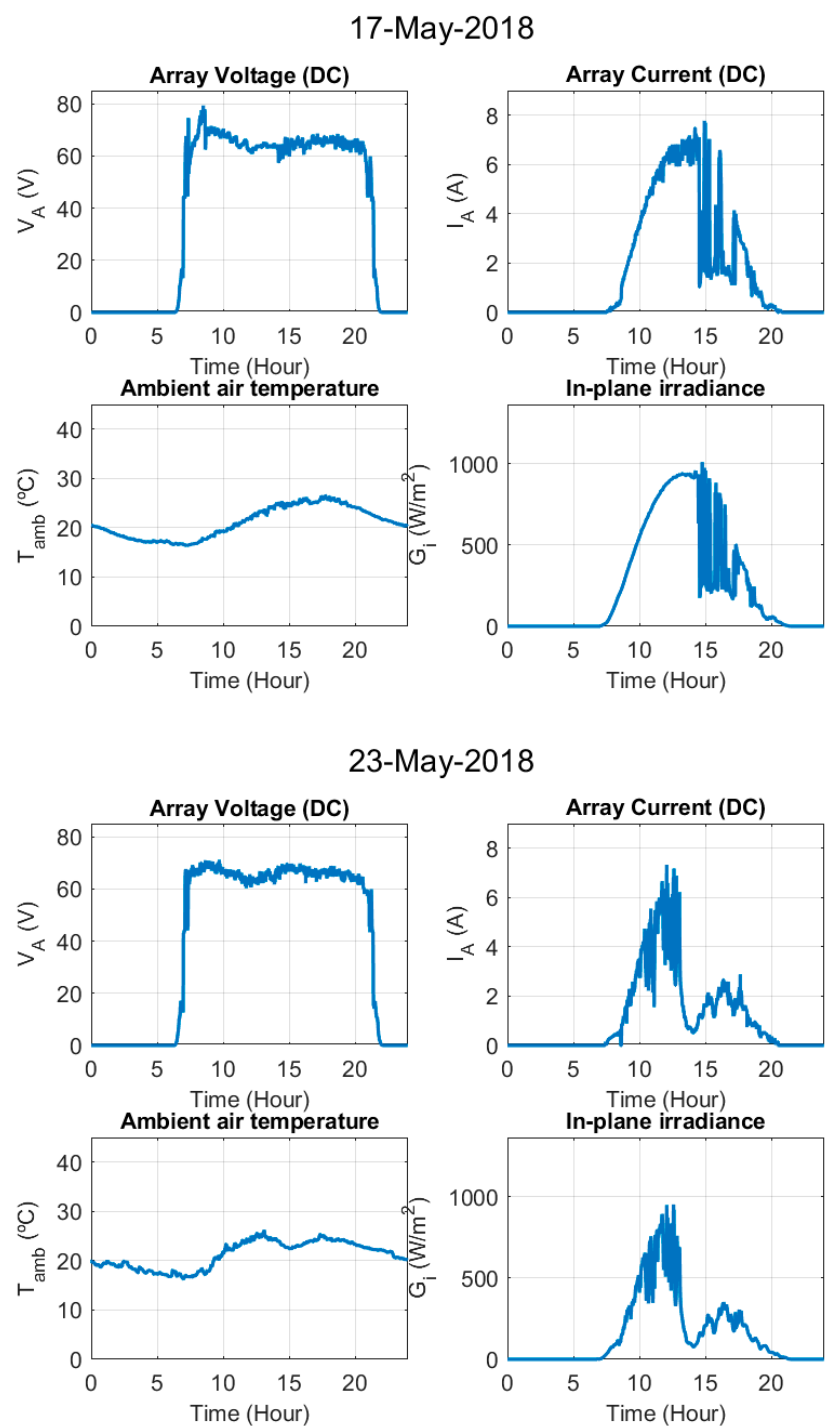
Figure A1. Daily monitored data (V A , I A , T amb and G i ) for a cloudy and a sunny day for each month from June 2017 to May 2018.